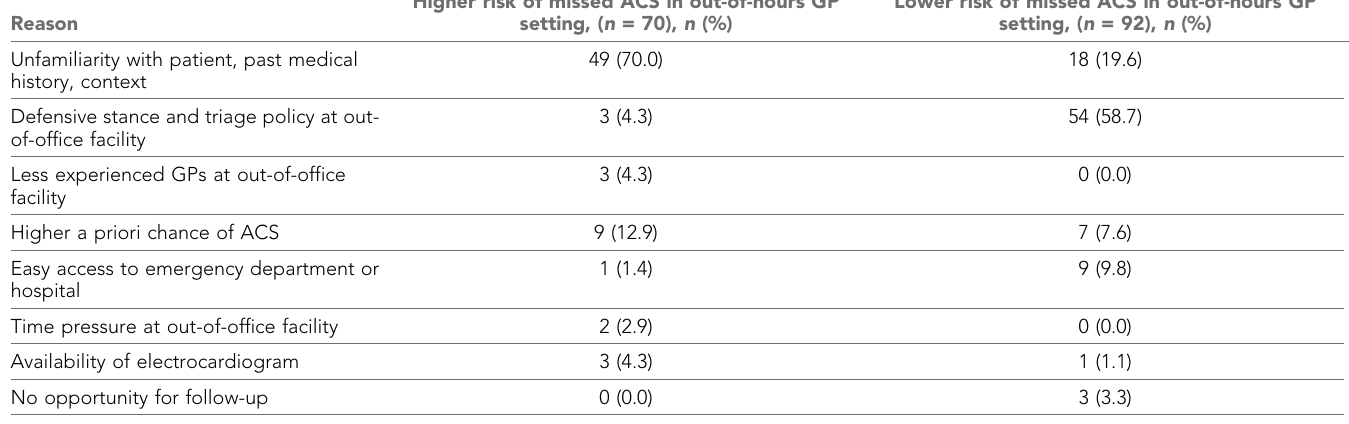
Table 2. Reasons for perceived difference in risk of missed ACS between out-of-hours GP service and day-time practice ( n = 162) Reason